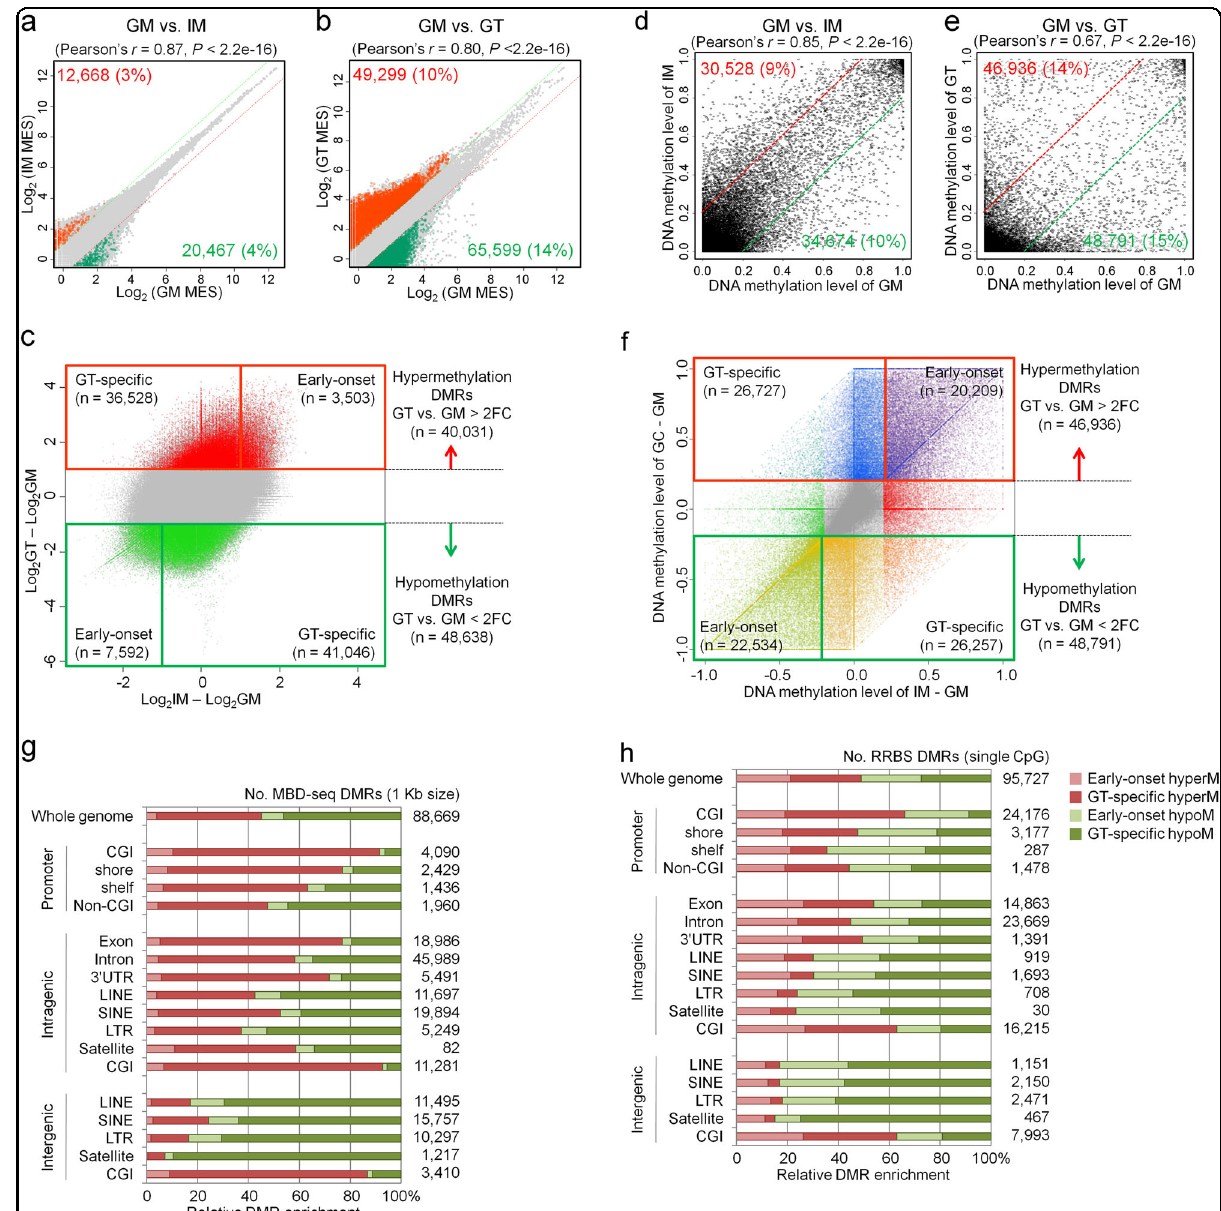
Fig. 3 Global comparison of three methylome datasets from MBD-seq and RRBS analyses of samples from a patient with GC. a , b For the MBD-seq data, a pairwise correlation of DNA methylation in 1 kb tiles was performed. The genomic tiling was obtained by sliding a 1 kb window through the genome such that each tile starts at the position where the previous tile moves 200 bp down. The average methylation value of each 1 kb tile was calculated, and 479,941 1-kb tiles had an average methylation value greater than 10 in at least one of the three cell types. Red or green spots indicate signi fi cant 2-fold increases (hypermethylation) or decreases (hypomethylation) between the data sets. c Two-dimensional scatter plot of the MBD-seq data. d , e For the RRBS data, a pairwise correlation of the DNA methylation data at individual CpG sites was performed. Red or green lines indicate 20% increased methylation levels (hypermethylation) or 20% decreased methylation levels (hypomethylation) between the cell types. f Two-dimensional scatter plot of the RRBS data. g , h Genomic distribution of DMRs according to the genomic features in the MBD-seq and RRBS